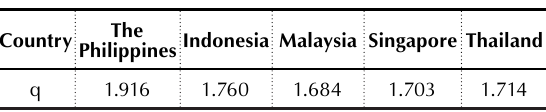
Table 6. Order q of returning series